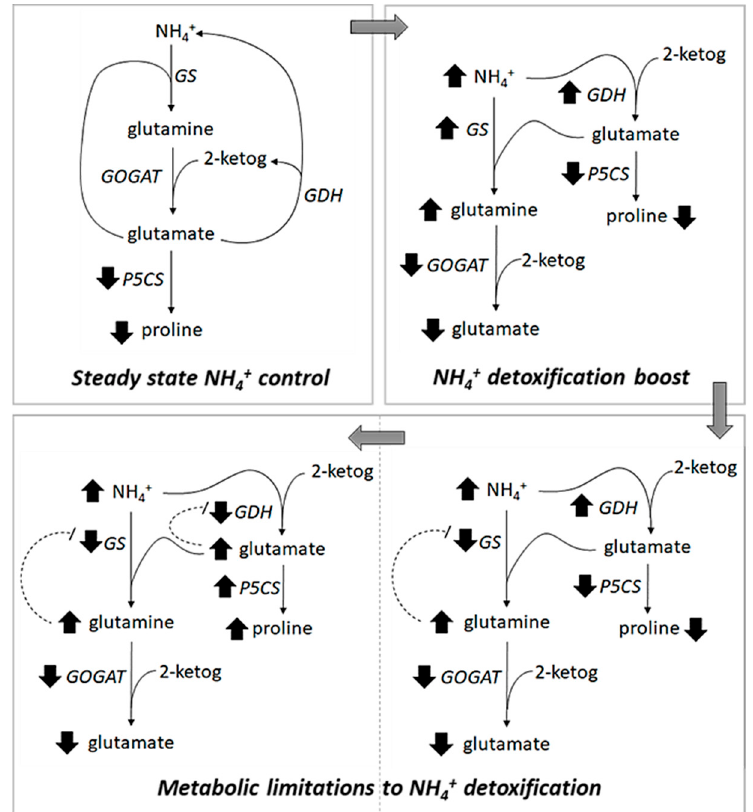
Figure 6. A proposed model for NH 4 + detoxification in plants. A model for ammonium assimilation in response to direct / indirect causes of NH 4 + accumulation in plants is proposed. Steady state NH 4 + control: under 200 mM NaCl, an ideal concentration for the growth of Salicornia, GS is upregulated to detoxify cells from salinity induced NH 4 + accumulation. In this phase, GS alone is able to incorporate NH 4 + into glutamine and GDH is set on its glutamate deaminating mode. In this scenario, cellular NH 4 + levels are maintained low. NH 4 + detoxification boost: when NH 4 + begins to build up (due to plants exposure to higher / toxic NaCl levels and / or an extra source of NH 4 + ), GOGAT is deactivated due to low levels of α -ketoglutarate that is used by an intense GDH activity. The GDH activity is set